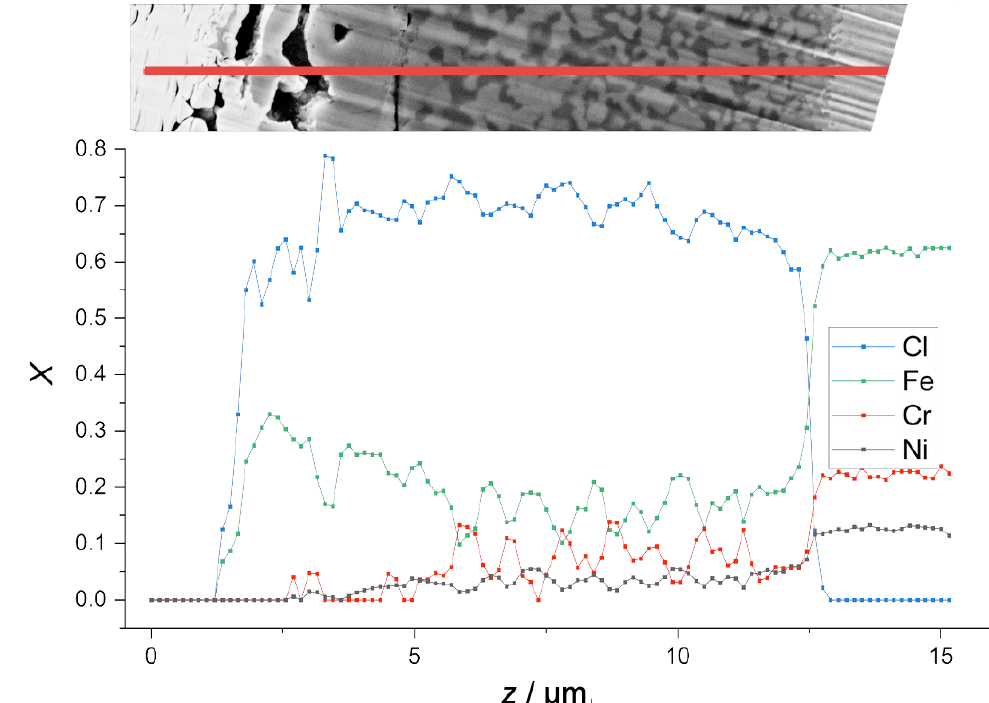
Figure 7. XEDS line scan along the line shown in red through the SEM image of the FIB-cut sub- surface zone of AISI-316L sample TX activated by 15 N 2 H 4 Cl reagent pyrolysis. The plot below displays the variation of the local atom fraction X of Cl, Fe, Cr, and Ni along the scan line. The atom fractions were obtained from the measured corresponding local intensities of element-characteristic X-rays, taking into account